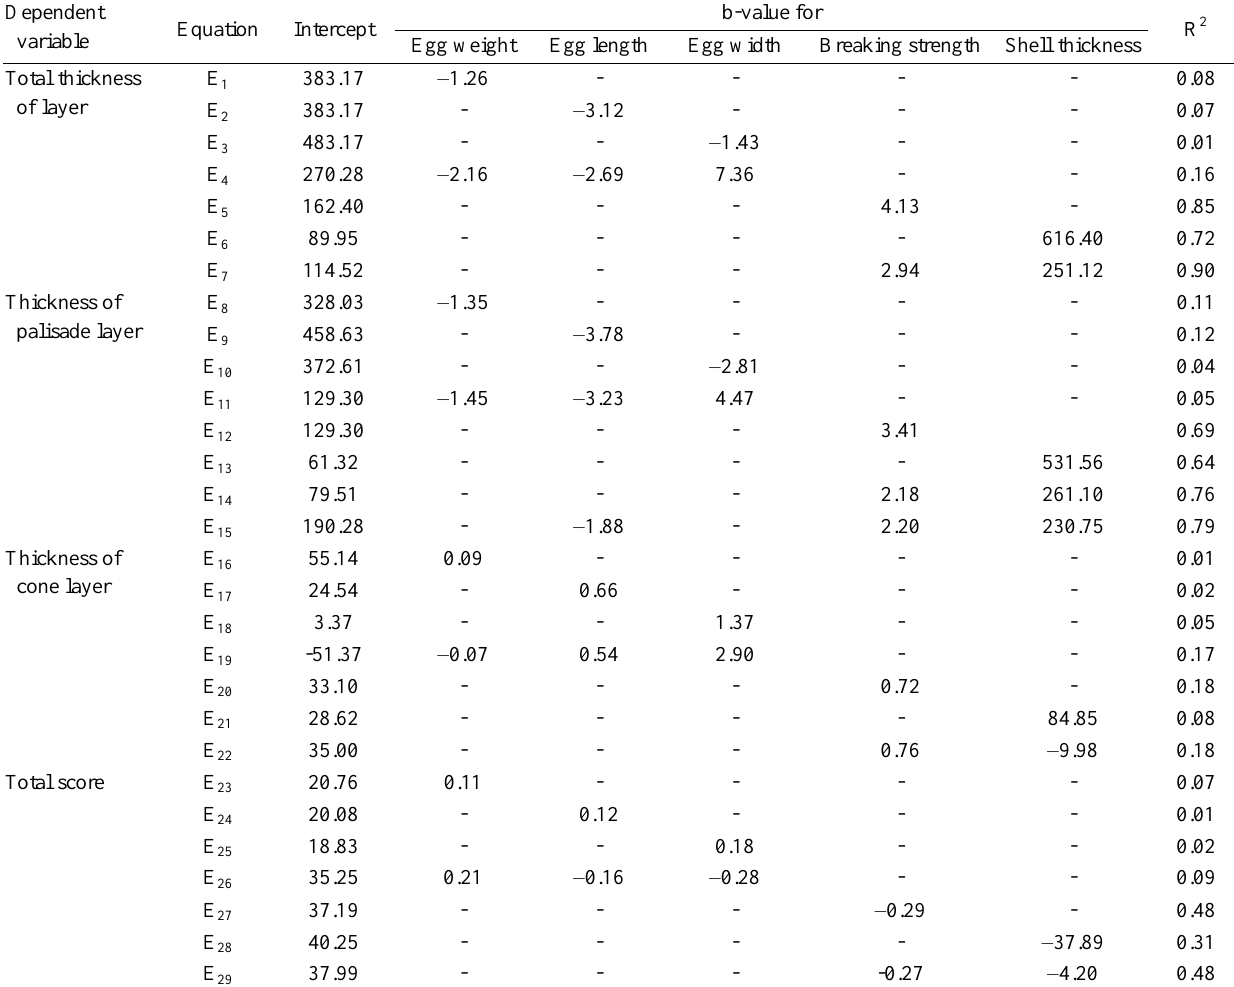
Table 4. Regression of some ultrastructure egg shell traits on direct non-destructive and destructive measurements Dependent variable